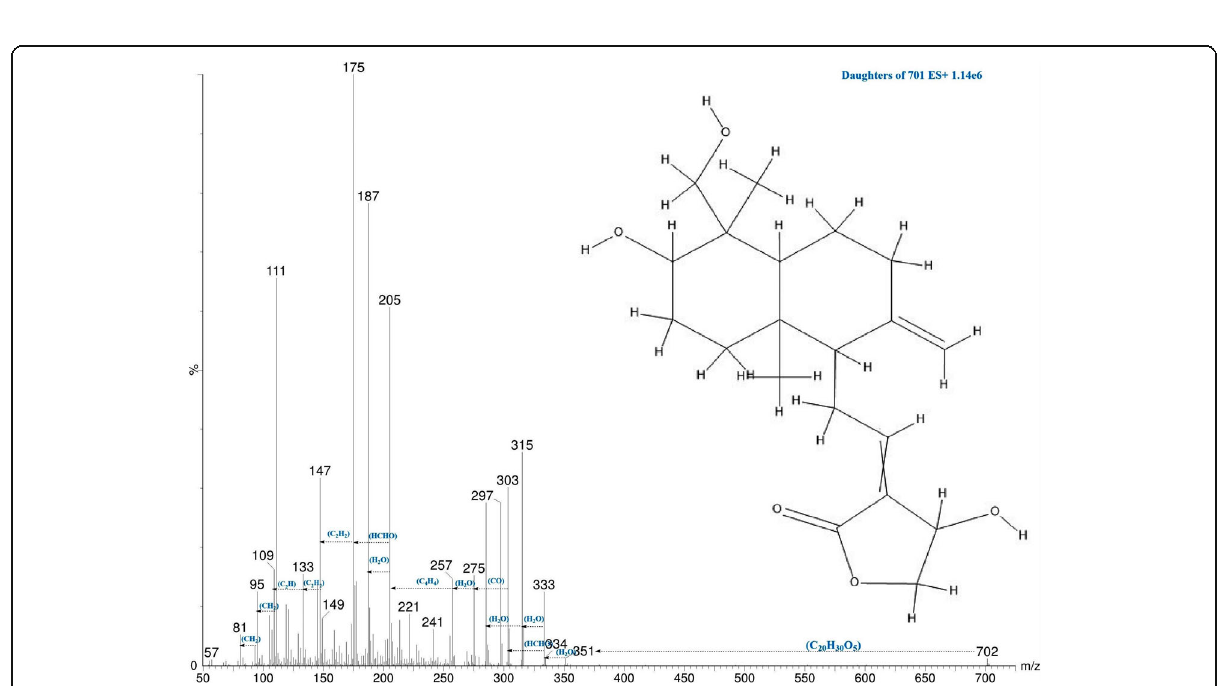
Fig. 10 Fragmentation pathway of Andrographolide